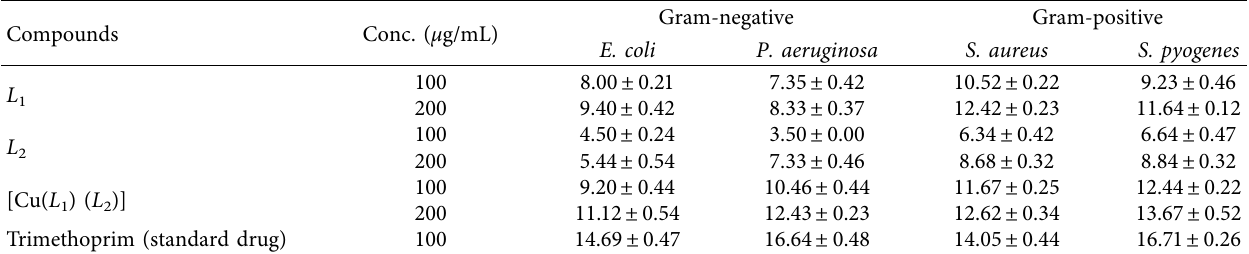
Table 2: Antibacterial activity results of the compounds.